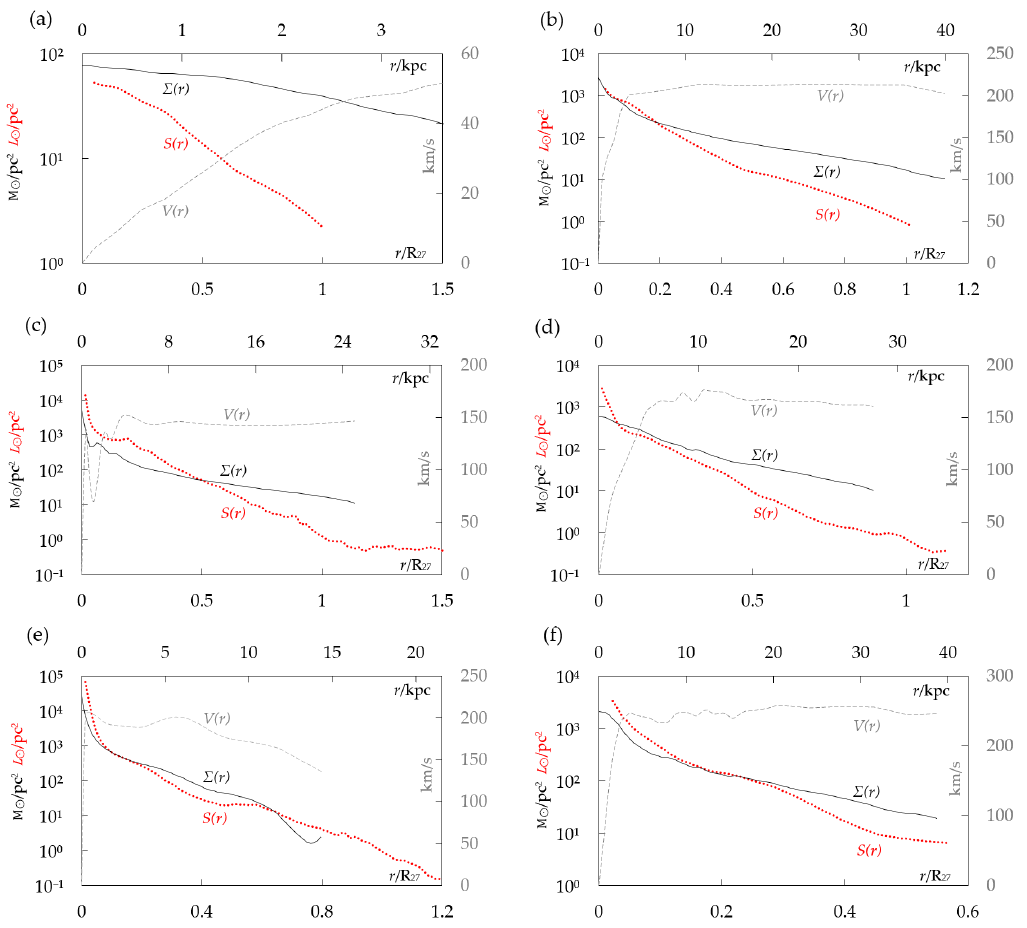
Figure 10. Representative cases from a 132-strong subsample of galaxies which do not show any excess density within observational radii: ( a ) NGC2366; ( b ) NGC2998; ( c ) NGC4303; ( d ) NGC1090; ( e ) NGC1808; ( f ) NGC6195. Twenty-five galaxies in this subsample have both RC and surface brightness profile length > R 27 , while for the remaining 107 galaxies, either RC or surface brightness profile length is shorter than R 27 . Red and black curves represent surface brightness S(r) in L (cid:12) ,3.6 / pc 2 and surface mass density in M (cid:12) / pc 2 , respectively ( left side Y-axis ). The dashed grey curve is the rotation curve V(r) in km / s ( right side Y-axis ). Lower X-axis is in units of r / R 27. Upper X-axis is in units of r / kpc. Toprovideabalancedandproportionalillustrationofoursample,